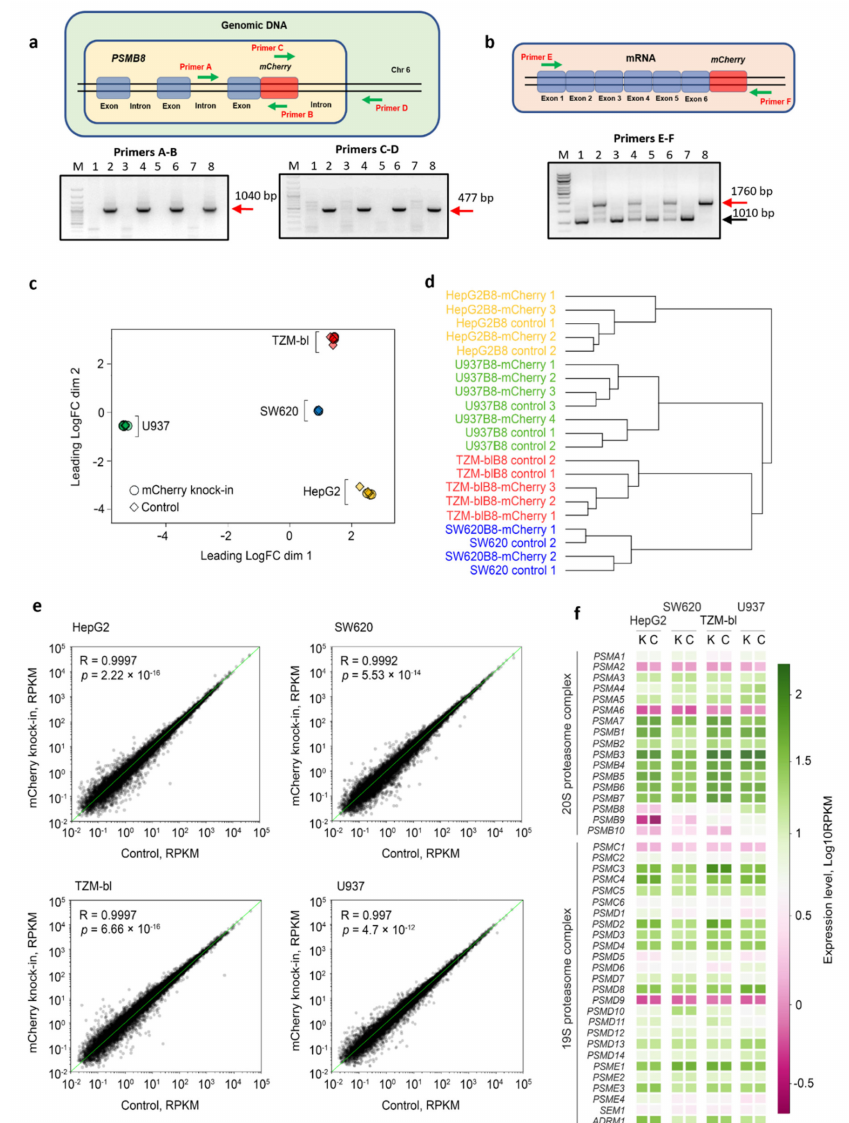
Figure 1. The mCherry gene is integrated into the genome and expressed in modified cells. Analysis of the gene expression in edited cells. ( a ) Gene knock-in in U937B8-mCherry, SW620B8-mCherry, TZM-blB8mCherry and HepG2B8mCherry cells was confirmed by PCR with two sets of primers using isolated genomic DNA. Following the PCR, the amplicons with expected size (1040 and 477 bp) were revealed in samples from modified cells but not control cells. Tracks are in order: ( M ) 100 bp DNA Ladder; ( 1 ) HepG2; ( 2 ) HepG2B8mCherry; ( 3 ) TZM-bl; ( 4 ) TZM-blB8mCherry; ( 5 ) U937; ( 6 ) U937B8-mCherry; ( 7 ) SW620; ( 8 ) SW620B8-mCherry. ( b ) The expression of PSMB8-mCherry chimera in modified cells was confirmed by RT-PCR. The total RNA was obtained from control and edited cells, cDNA synthesis was performed. The 1760 bp fragment represents full-length chimeric transcript, while the 1010 bp fragment corresponds to the wild-type PSMB8 transcript. Tracks are in order: ( M ) 100 bp DNA Ladder; ( 1 ) SW620; ( 2 ) SW620B8-mCherry; ( 3 ) HepG2; ( 4 ) HepG2B8mCherry; ( 5 ) U937; ( 6 ) U937B8-mCherry; ( 7 ) TZM-bl; ( 8 ) TZM-blB8mCherry. Comparative analysis of gene expression profiles of mCherry knock-in and original cell lines. ( c ) Multidimensional scaling (MDS) plot of pairwise distances calculated using root- mean-square of Log2FoldChange values between experimental groups. ( d ) Canberra distance calculated between each sample. Samples were clustered using hierarchical clustering analysis, and the dendrograms represent the clustering results. ( e ) Scatter plots demonstrating the relation of expression values (reads per kilobase per million mapped reads, RPKM) between mCherry knock-in and original cell lines. R-Pearson’s correlation coefficient, p -value calculated for the most variable genes (upper 75 percentile). ( f ) Heatmap depicting expression levels of the 20S and 19S proteasome complex genes (RPKM) in knock-in and original cell lines. K–mCherry knock-in cells, C–control